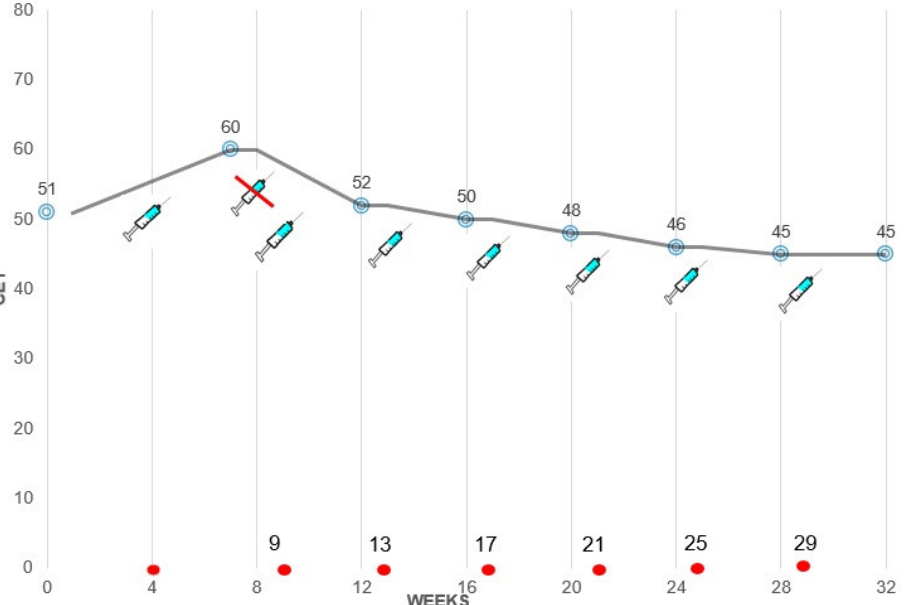
Figure 4. Graph showing the changes of average values of corneal epithelial thickness (CET) measured in 5 sectors according to the infusion of belamaf in a representative patient. After the first dose, an increase in CET with the appearance of central MECs and vision reduction were found. The second dose was therefore delayed by one week. After the third and the fourth dose, a diffuse decrease in CET was assessed, followed by a “plateau phase” after the fifth dose. CET values are expressed in micron.